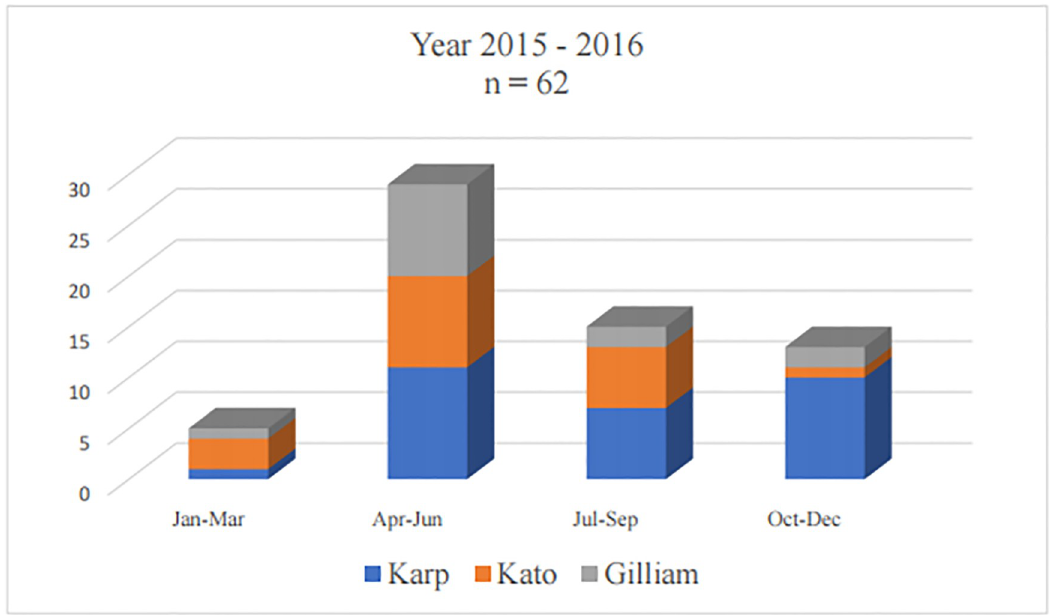
Fig 1. Month of hospital presentation of circulating genogroups during